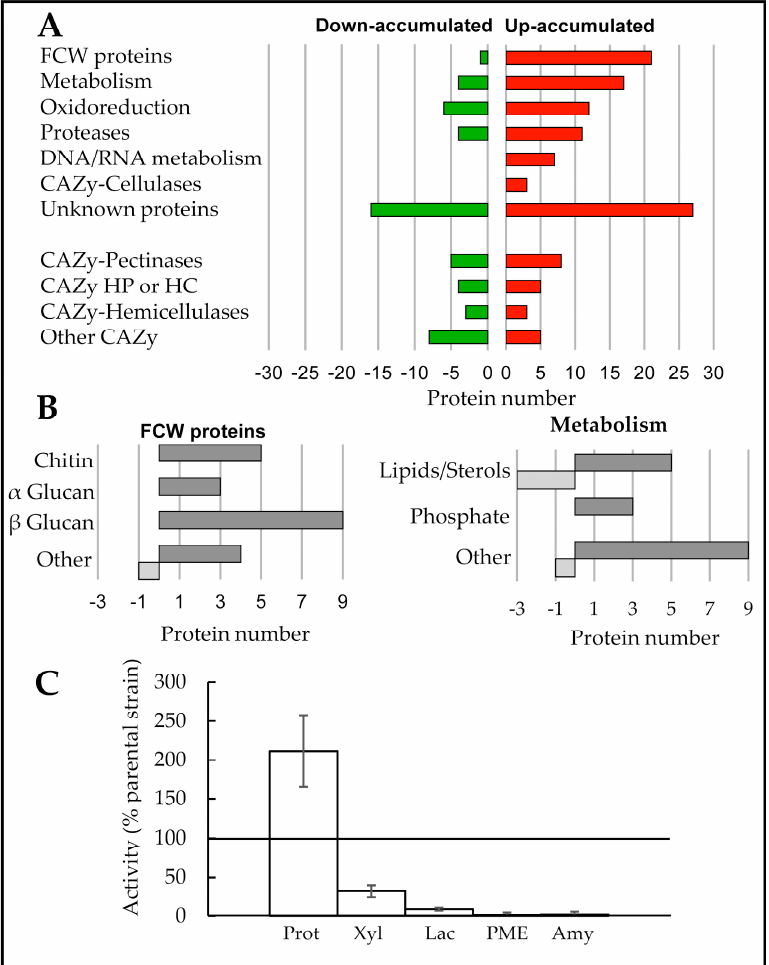
Figure 6. BcCps1 influences the fungal exoproteome. ( A ) Comparative shotgun analysis of the pro- teins present in the supernatants of 3-days liquid cultures of the parental and Δ Bccps1 mutant strains. The proteins down- or up-accumulated in the mutant exoproteome are classified according to their functional category (fold change ≥ two, occurrence ≥ three of four biological replicates, see Table S3). CAZy, carbohydrate active enzymes; FCW, fungal cell wall; HP, hemicellulose pectin; HC, hemicellulose cellulose. ( B ) Sub-categorization of the categories « FCW proteins » and « Metabolism » (see Table S3). The down-accumulated proteins (green) are plotted as negative numbers. ( C ) Enzymatic activities measured on the same supernatants used for the proteomic analysis (four replicates). The results are shown as percentages of the parental strain values. PMEs; pectin methyl esterases. Means and standard deviations were calculated from three independent experiments ( n = 12). 100% activity in the parental strain correspond to 0.41 OD 280 /mg dry mycelium (Proteases), 36 RFU/min.mg dry mycelium (Xylanases), 7.9 × 10 − 3 RFU/min.mg dry mycelium (Laccases), 2.35 cm/40 µL supernatant (PMEs) and 2 cm/40 µL supernatant (Amylases).